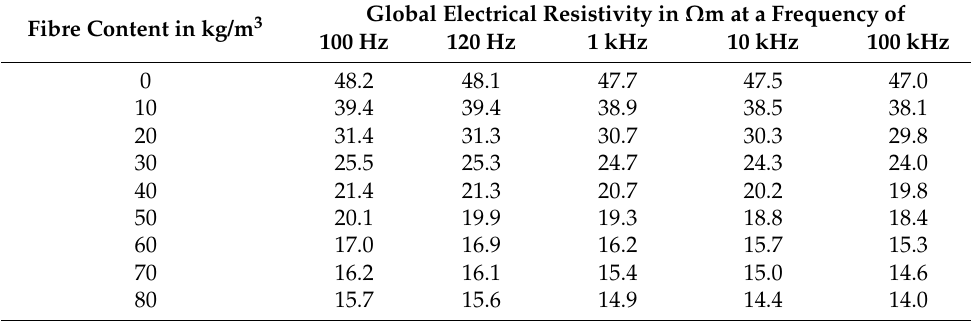
Table A27. Results of the resistivity measurements of the concrete mixture 32-55-270-35. Fibre Content in kg/m 3